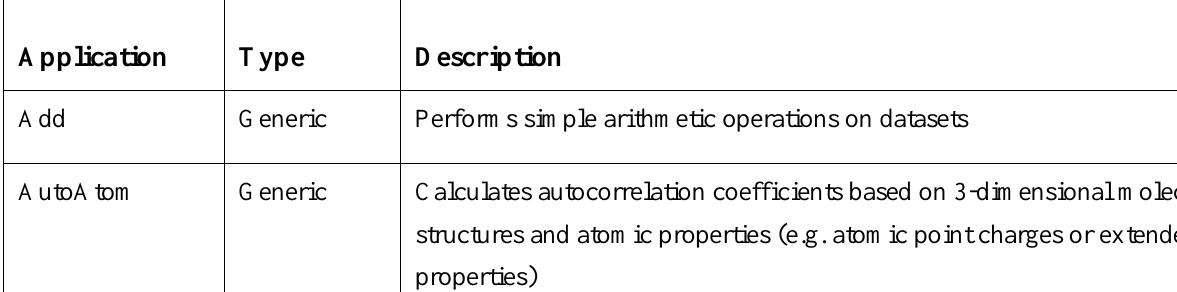
Table 1: Example applications for use within a marvin